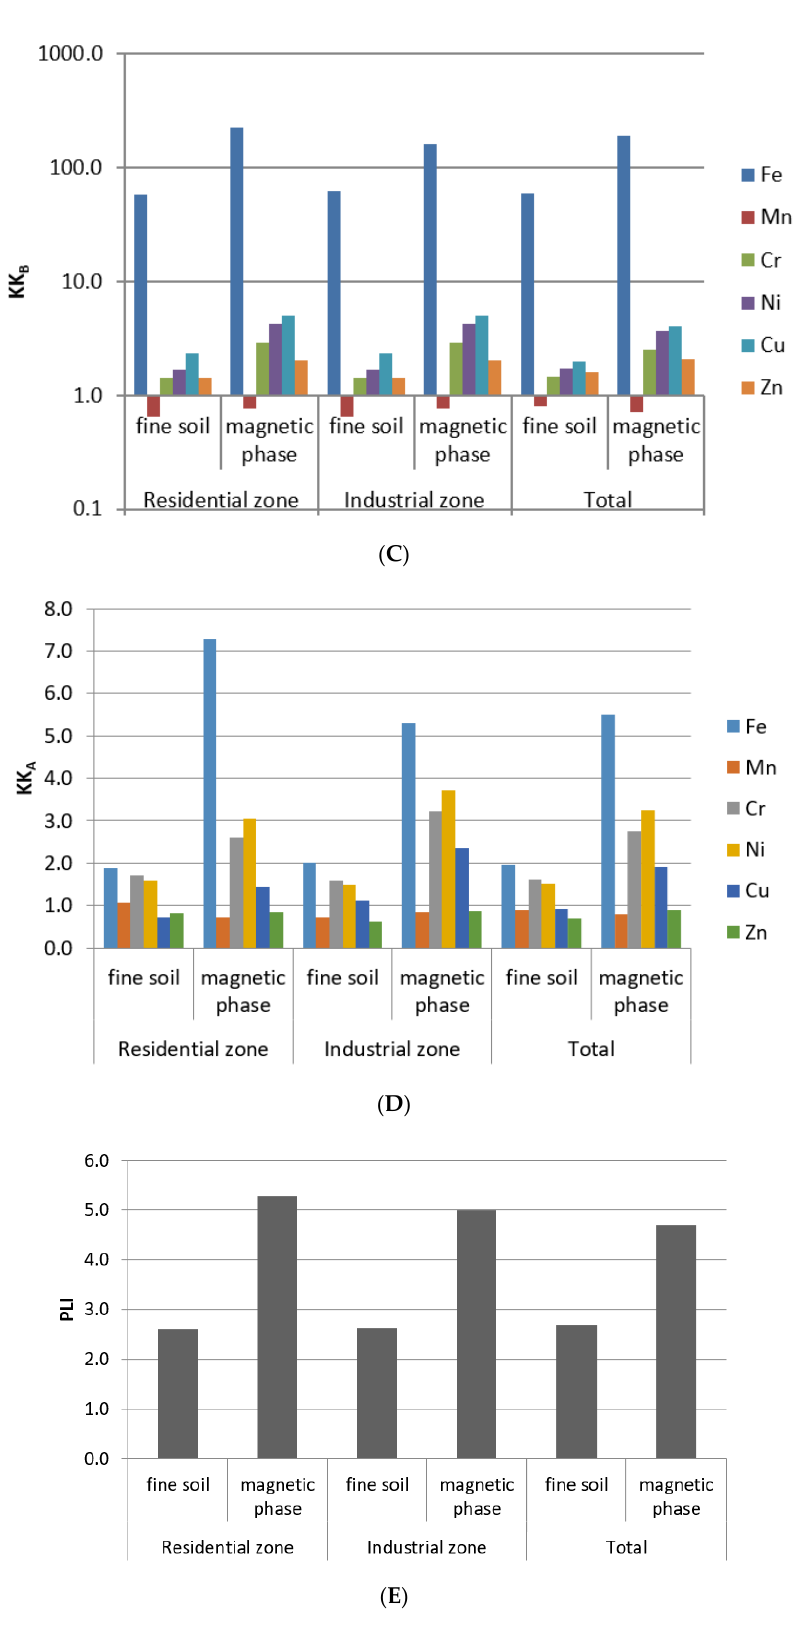
Figure 10. Geochemical sequences for soils of Gubakha: ( A ) Coe ffi cient of enrichment of the magnetic phase in heavy metals, KK m.f. ; ( B ) Geo-accumulation Index, I geo ; ( C ) Coe ffi cient of concentration relative to the background, KK B ; ( D ) Coe ffi cient of concentration relative to the clarke of soils of residential landscapes in Russia according to V.A. Alekseenko, KK A ; ( E ) Pollution load index,